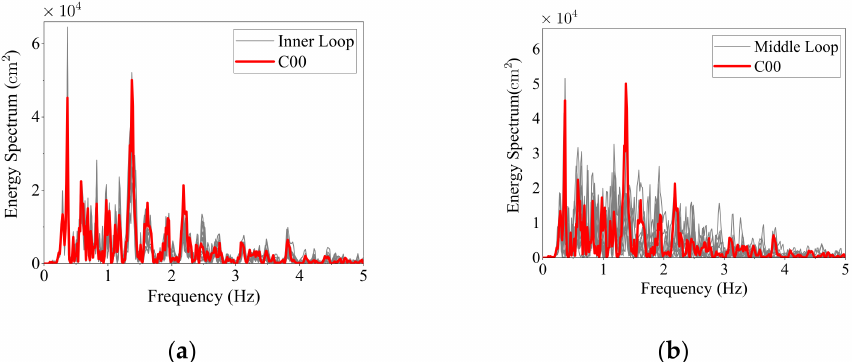
Figure 9. Comparison of energy spectra between the center station and the loop stations in Event 45EW: ( a ) Inner Loop, ( b ) Middle